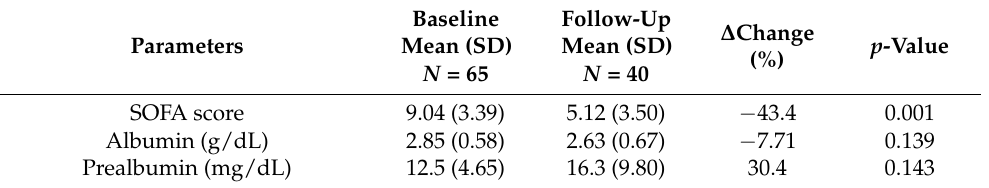
Figure 1. Associations between the antioxidant enzymes and main parameters of the study at the baseline and follow-up. ( a ) GPx with APACHE II at the baseline. ( b ) GPx with SOFA at the baseline. ( c ) GPx with erythrocyte Se at baseline. ( d ) SOD with albumin at follow-up. ( e ) TAC with albumin at follow-up. ( f ) SOD with TAC at follow-up. Abbreviations: APACHE-II = Acute Physiology and Chronic Health Evaluation II; GPx = Glutathione Peroxidase; Hb = Hemoglobin; SOD = Superoxide Dismutase; SOFA = Sequential Organ Failure Assessment; TAC = Total Antioxidant Capacity. Pearson’s correlation coefficient (r) was used to associate all parameters. Statistical significance was considered for p < 0.05. Table 2. Comparative analysis of the studied parameters at baseline and follow-up.